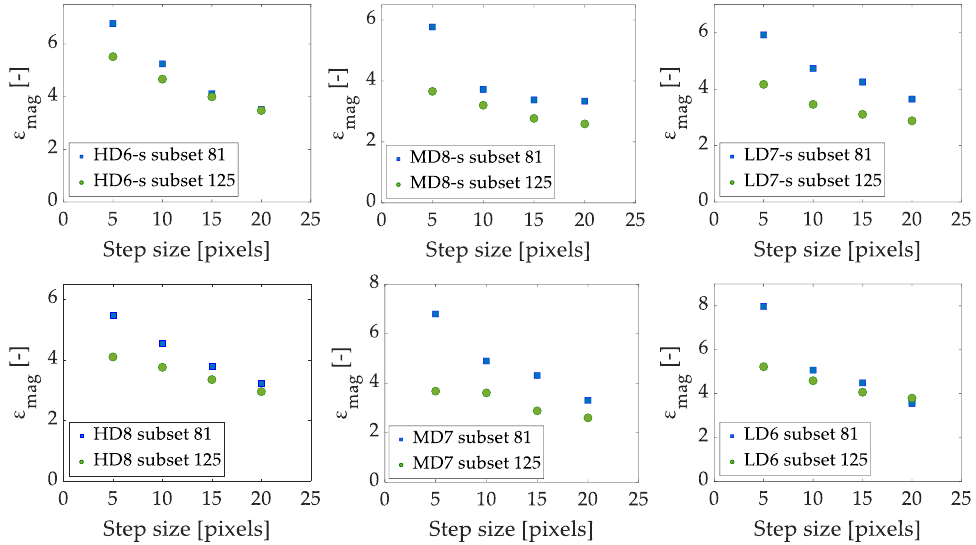
Figure 9. Effect of step size variation on the equivalent strain magnification at the apparent ultimate point for speckled specimens HD6, MD8 and LD7 ( top ) and non-speckled specimens HD8, MD7 and LD6 ( bottom ) for 81 and 125 pixels subset size. The extension -s denotes speckled